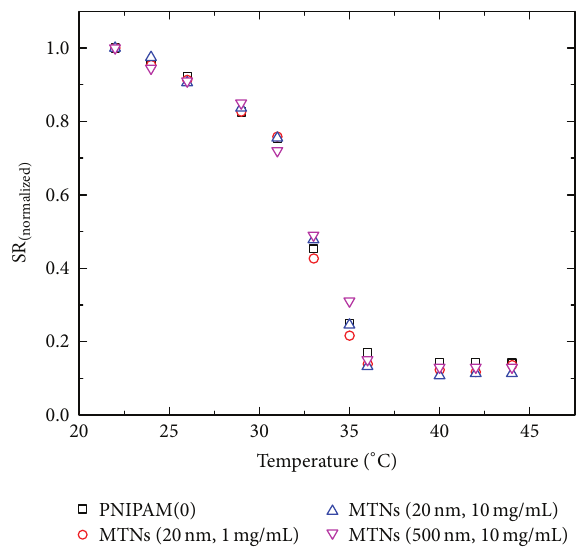
Figure 3: Swelling/deswelling ratio (normalized) of pure PNI- PAM microparticles (PNIPAM(0)) and different compositions of magneto-thermoresponsive nanocomposites (MTNs). The experi- ments were performed by direct heating; that is, the microparticles were immersed in a water bath of controllable